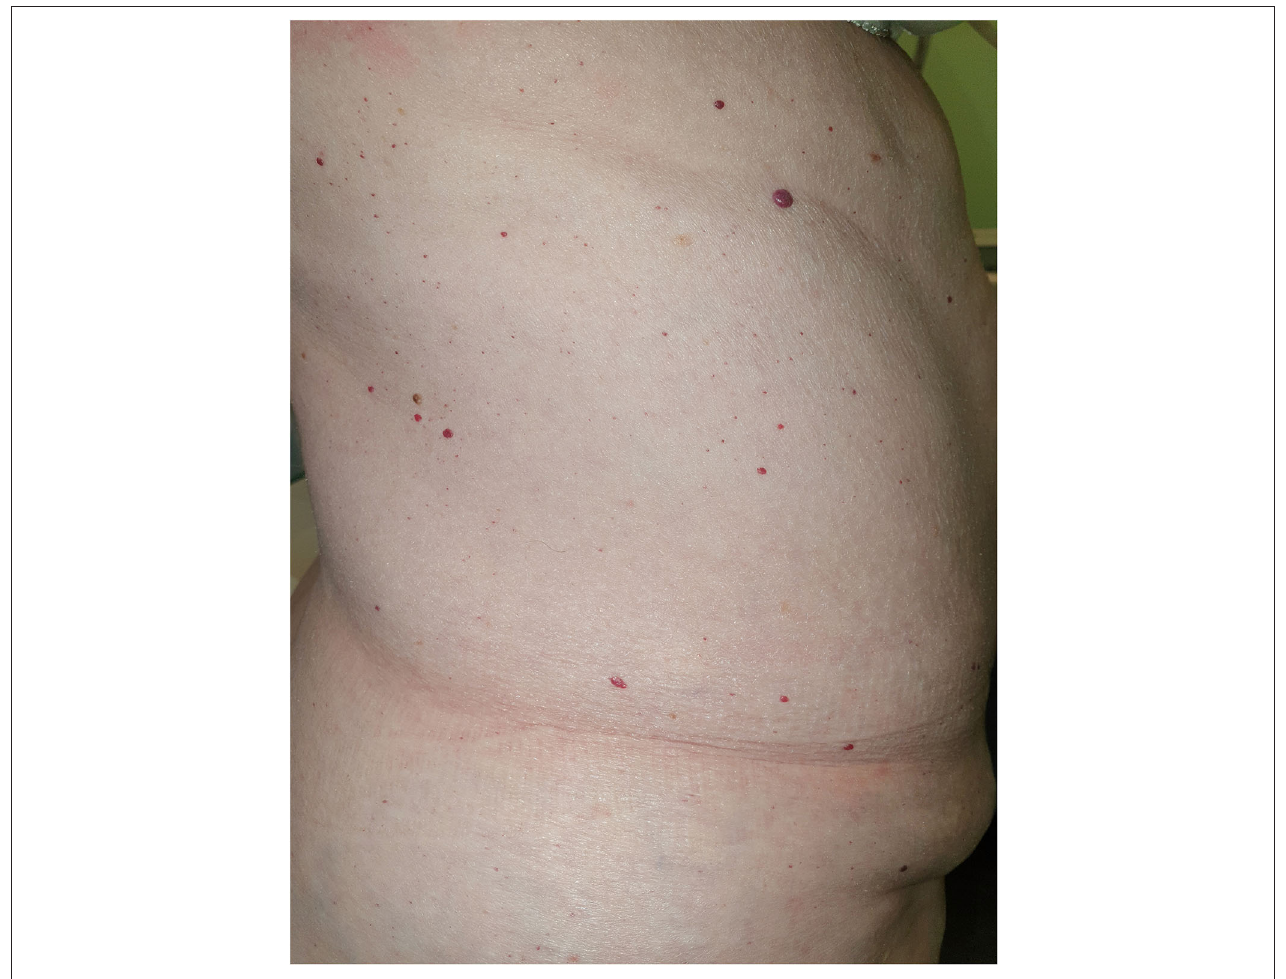
FIGURE 2 | Eruptive cherry angiomas in a patient with breast cancer and BRCA1